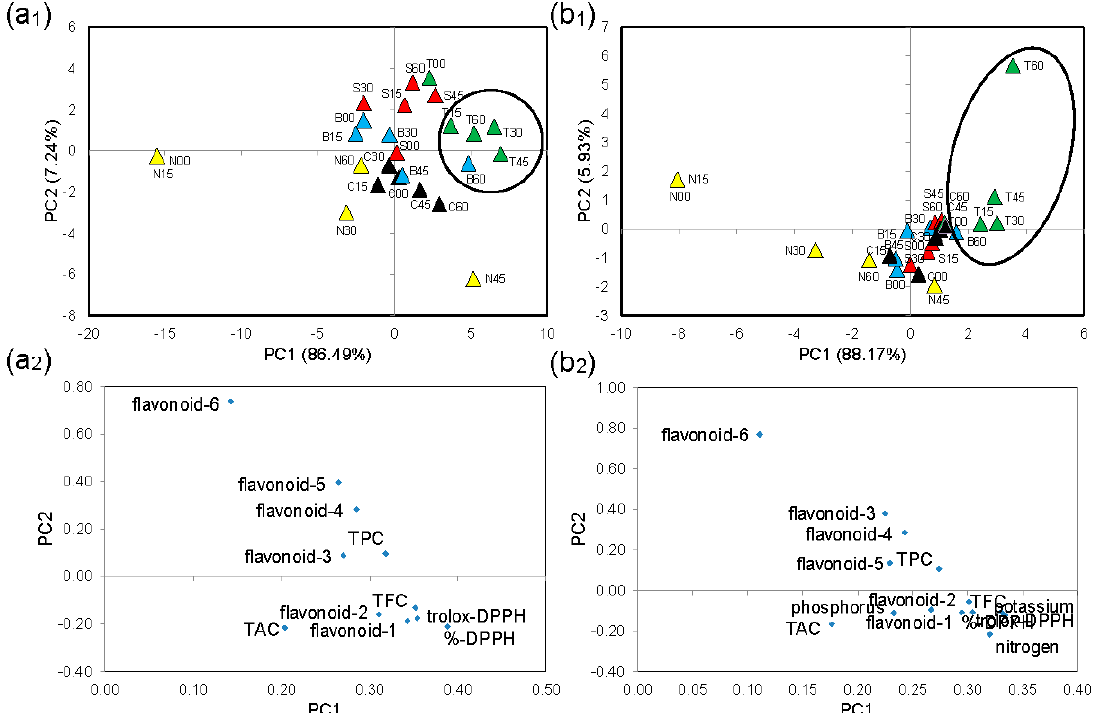
Figure 2. Score and loading biplots of PCA of 11 antioxidant variables ( a 1 , a 2 ), and of 3 nutritional and 11 antioxidant variables ( b 1 , b 2 ) evaluated in parsley grown in 25 organic substrates. B: bagasse–chicken compost, S: sawdust–chicken compost, T: tree–chicken compost, N: napier–chicken compost, C: cotton–chicken compost. The number following the compost letters corresponds to the proportion of biochar in the organic substrates.